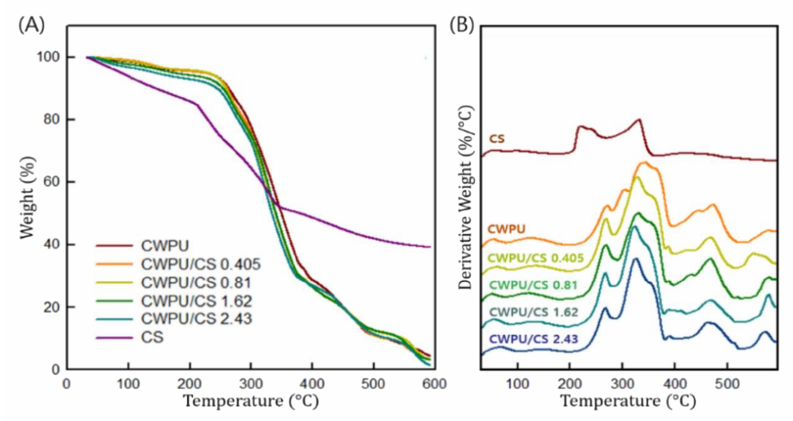
Figure 6. ( A ) TGA curves and ( B ) its derivative weight loss curves of CWPU and CWPU/CS nanocomposites with various CS contents.